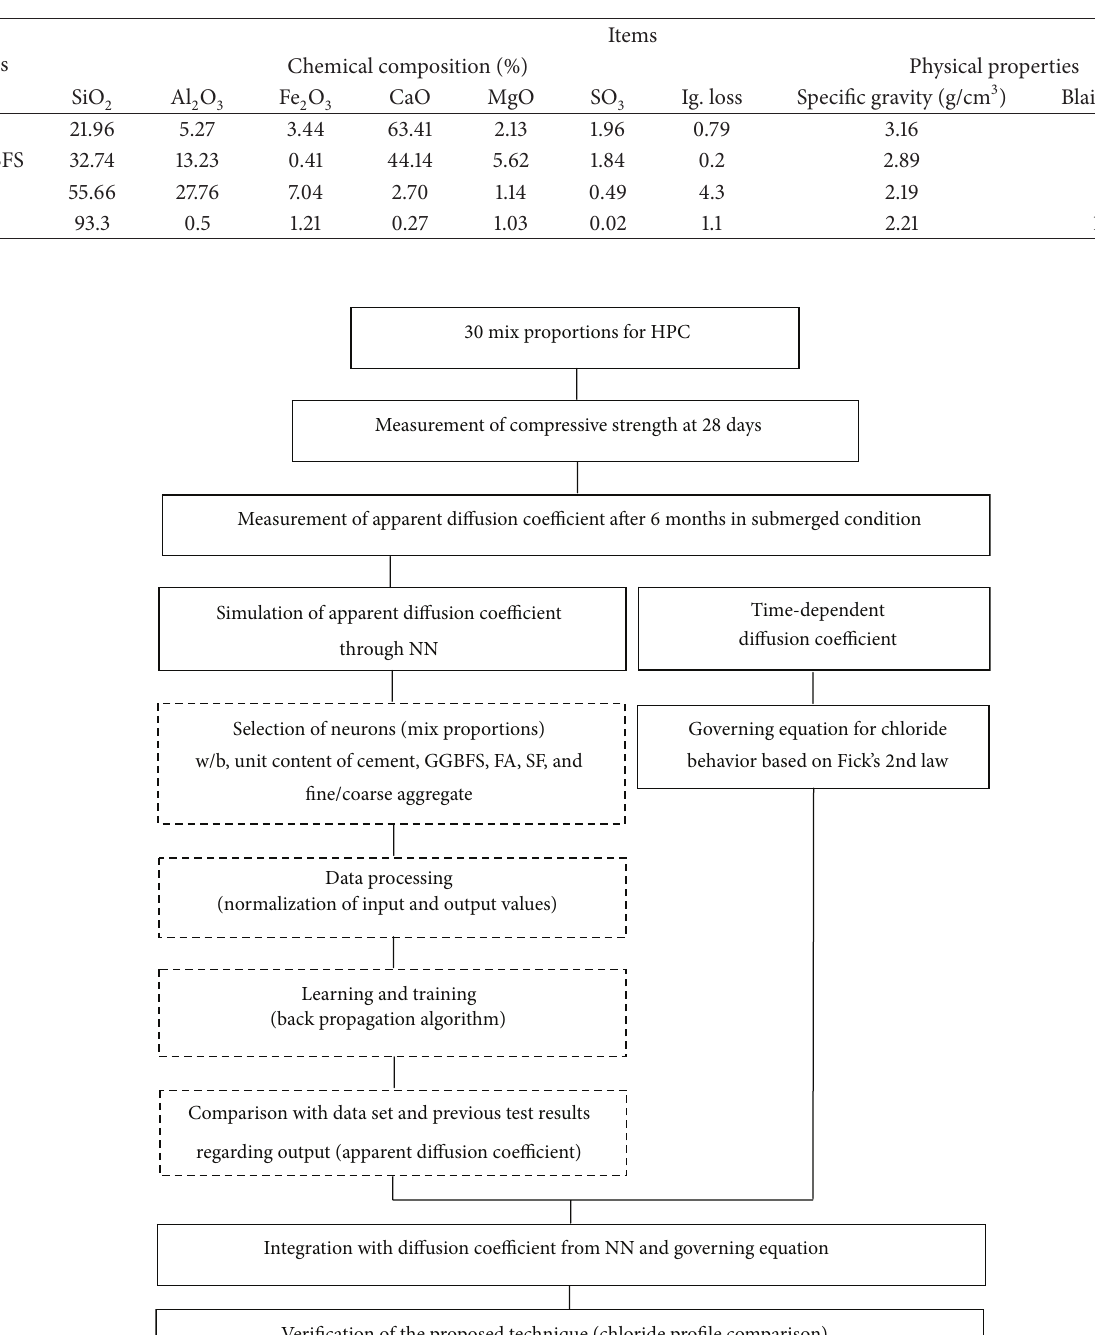
Table 1: Chemical and physical properties of cement and mineral admixtures.